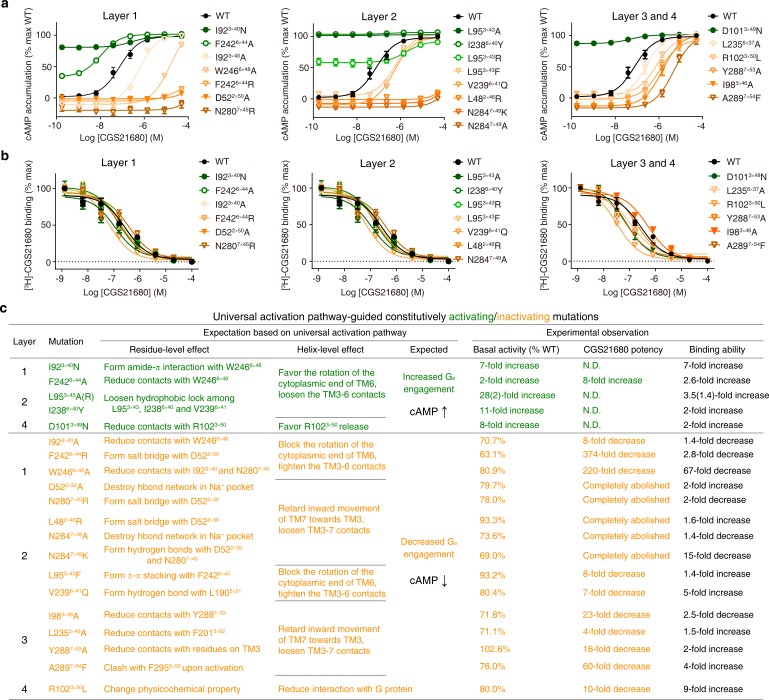
Experimental validation of the common activation mechanism.(a) cAMP accumulation assay and (b) radioligand binding assay: both validated the common activation pathway-guided design of CAMs/CIMs for A2AR. Wildtype (WT), CAMs and CIMs are shown in black, green and orange, respectively. (c) Mechanistic interpretation of common activation pathway-guided CAMs/CIMs design. N.D.: basal activity was too high to determine an accurate EC50 value.Figure 6—source data 1.Functional and ligand binding properties of A2AR mutations.Figure 6—source data 2.Analysis of the 14 unsuccessful predictions of A2AR CAMs/CIMs.ΔStability (>0 means destabilized;<0 means stabilized) is the change of receptor stability when a mutation was introduced, calculated by Residue Scanning module in BioLuminate (Beard et al., 2013). WT, wild-type.